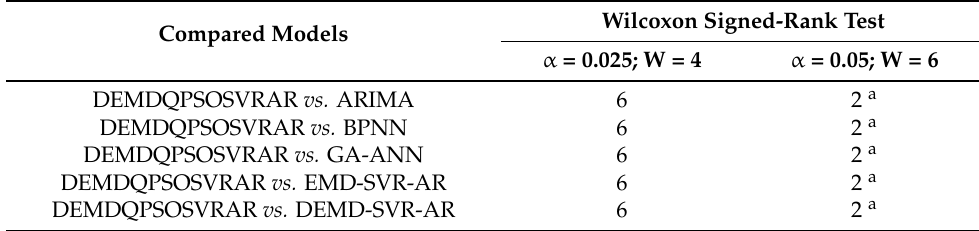
Table 10. Wilcoxon signed-rank test in Case